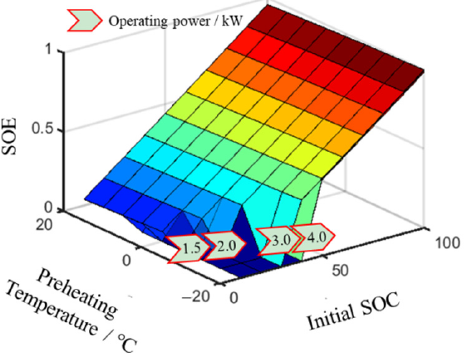
Figure 12. SOE of the module discharged at different constant powers at − 20 °C and with